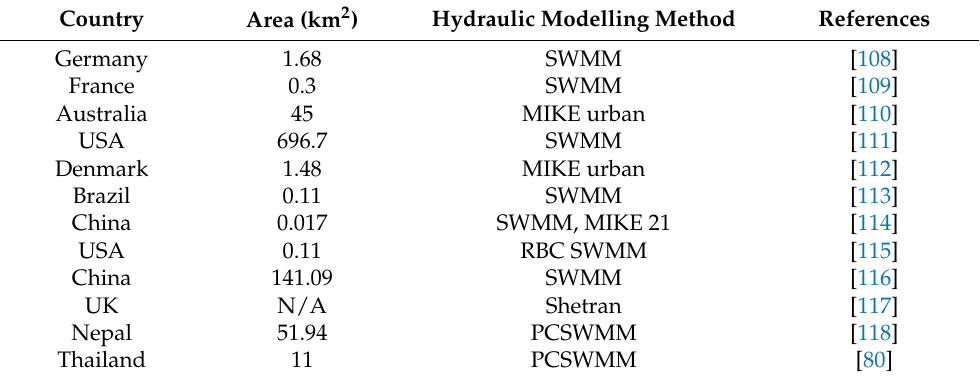
Table 1. Recent research on physical-process-based models for real-time urban flood forecasting